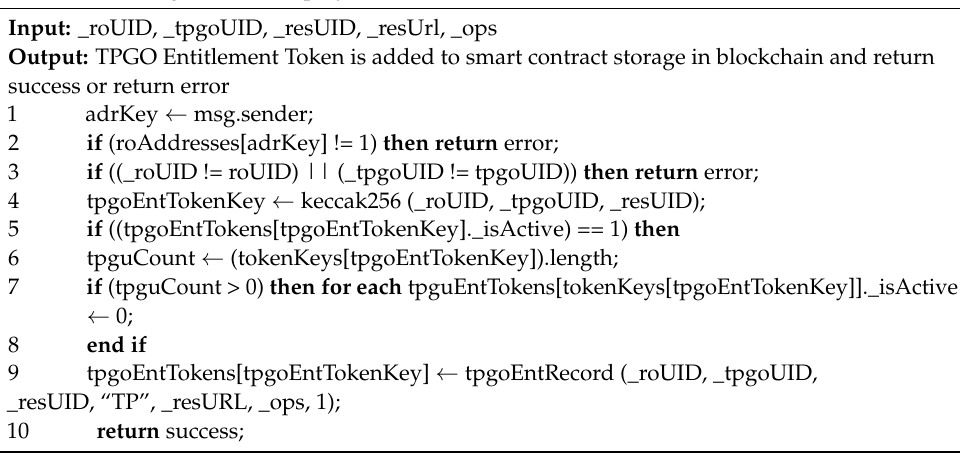
Algorithm 2: Algorithm to deploy a TPGO entitlement token in blockchain.